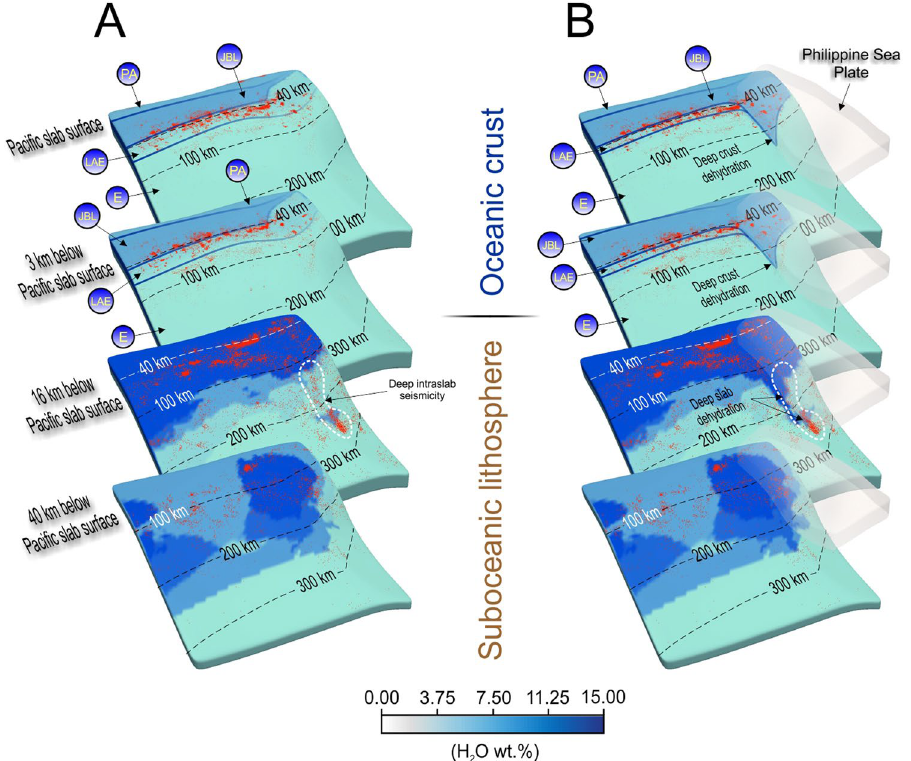
Figure 3. Pacific slab H 2 O and seismicity (red dots) distribution at different slab depth levels. ( A ) Numerical experiment with a single plate (Pacific). Light blue bands mark the metamorphic facies corresponding to the Pacific slab: PA – pumpellyite actinolite, JBL - jadeite blueschist lawsonite, LAE - lawsonite amphibole eclogite, E – eclogite. ( B ) Numerical experiment with double subduction. Philippine Sea plate is shown as a semitransparent surface. White dashed contour defines the location of a deep intraslab earthquake cluster inside the Pacific slab. At each slice the seismicity corresponds to ± 2 km measured from the slice surface for the oceanic crust, and ± 4 km for the suboceanic